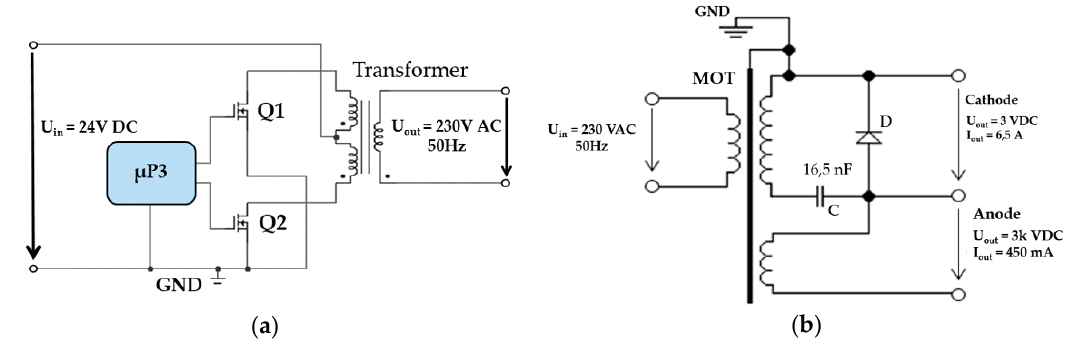
Figure 6. Schematics of the cascade converter subsystems. ( a ) DC / AC Push–Pull converter; ( b ) AC / DC converter with MOT [17,18].